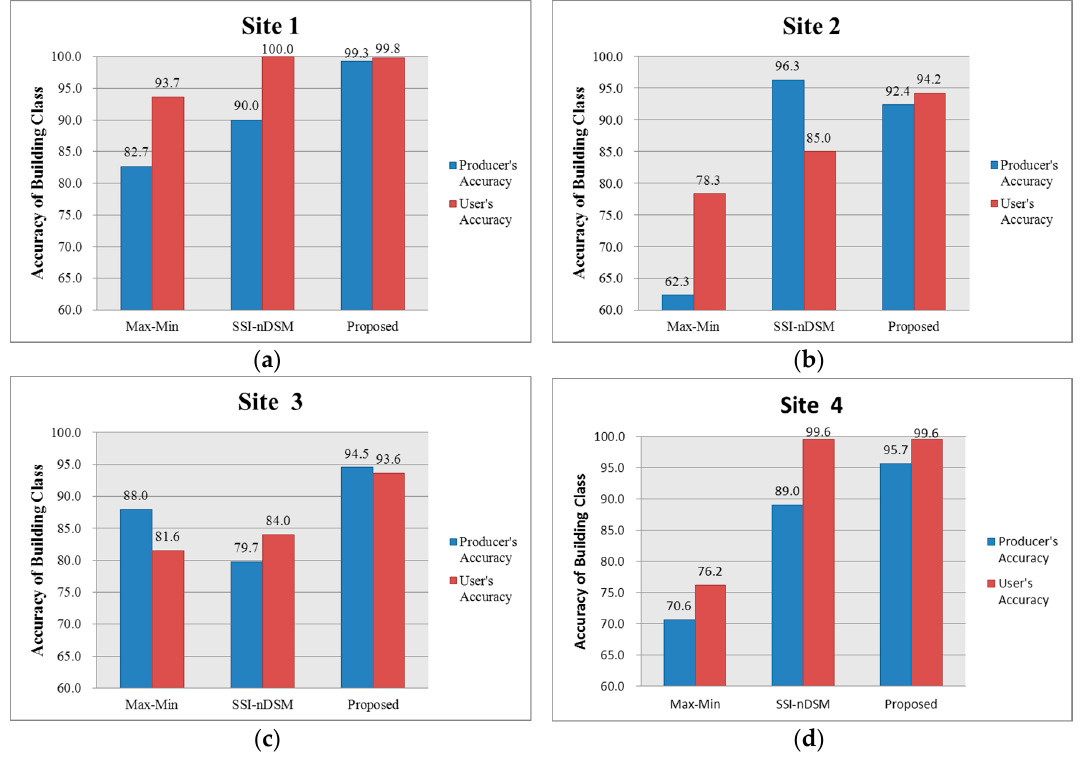
Figure 11. Producer’s and user’s accuracies for the building class: ( a ) site 1; ( b ) site 2; ( c ) site 3; and ( d ) site 4.